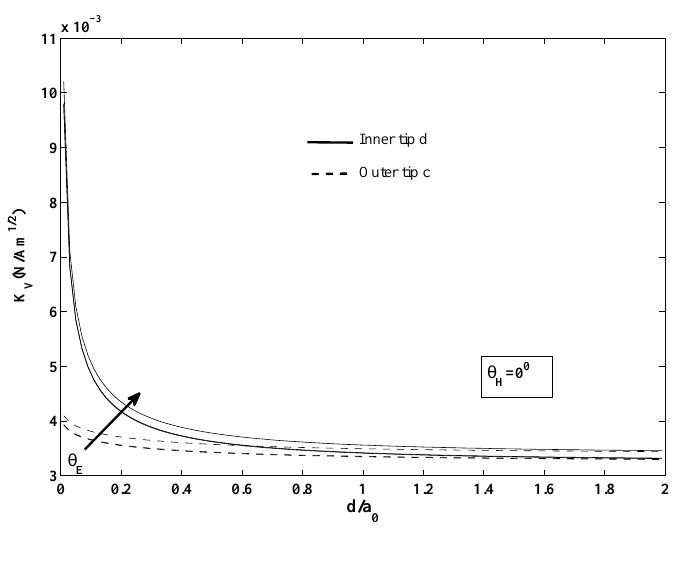
Fig. 8 MIIF versus inter-crack distance for different electric poling with fixed magnetic poling